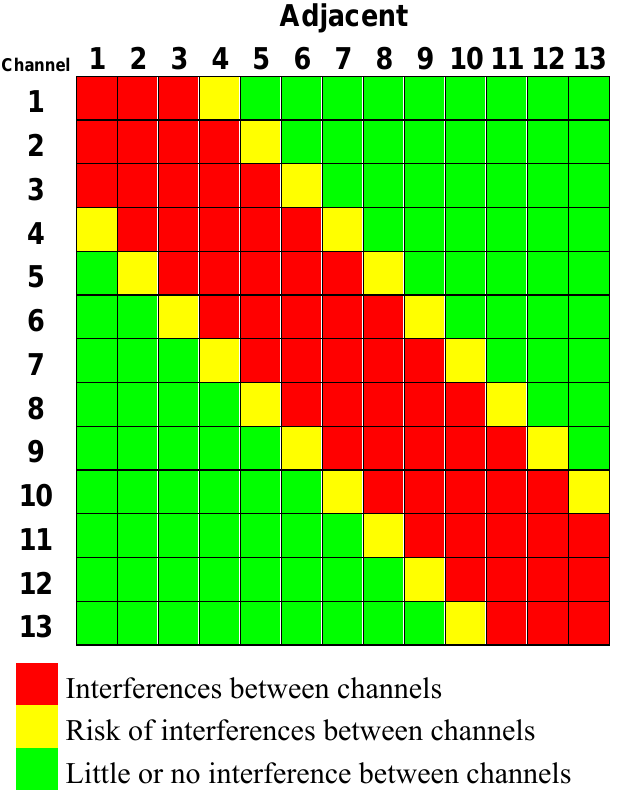
Table 2. An optimal 4-channel distribution over a horizontal